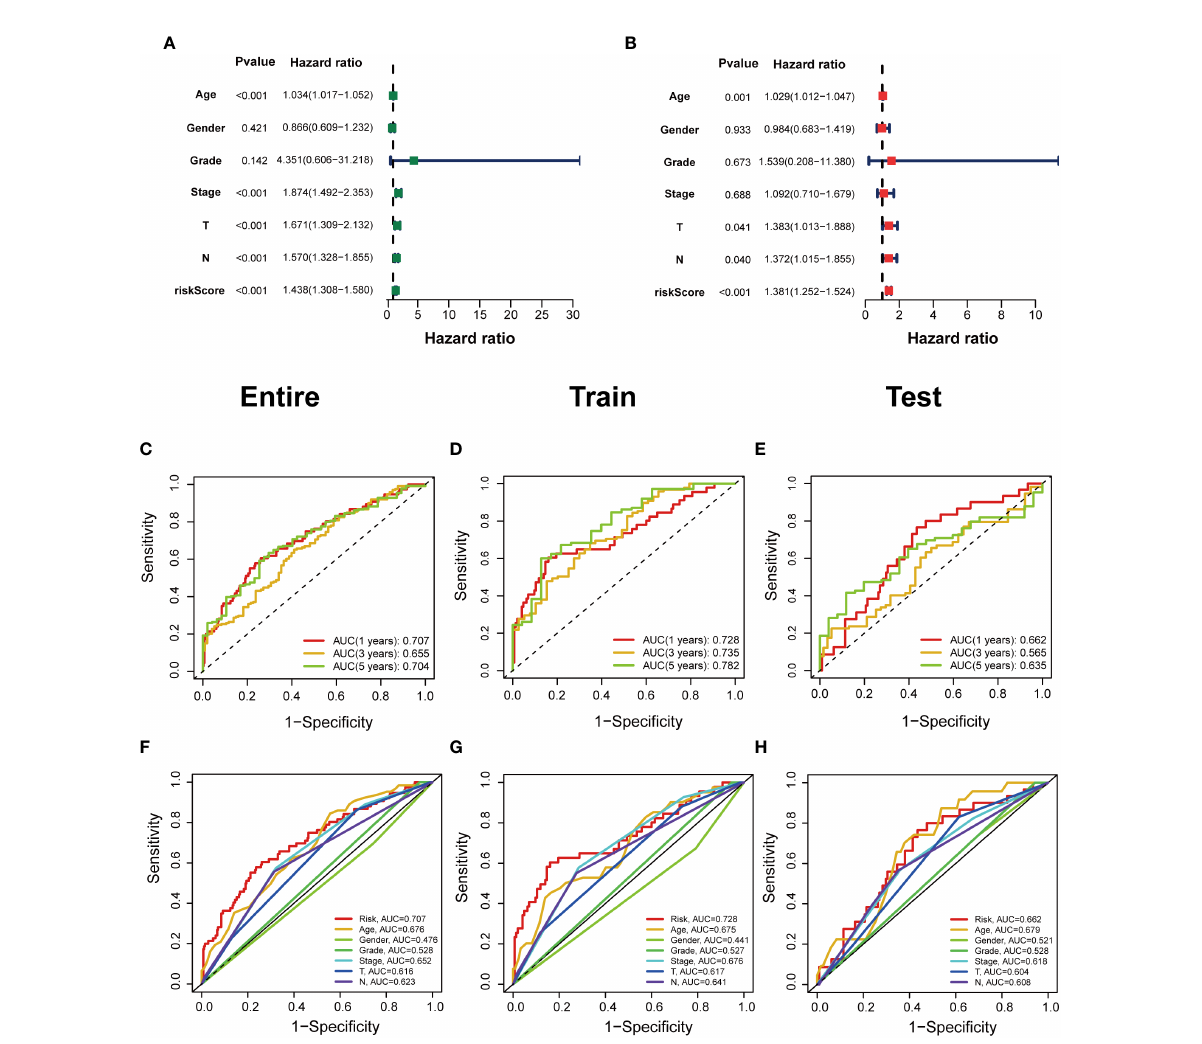
FIGURE 5 Independent prognostic value of clinical features in risk models. (A, B) Univariate Cox regression analysis and multivariate Cox regression analysis of clinical factors and risk scores. (C – E) Time-dependent ROC curves predict 1-year, 3-year, and 5-year overall survival for BCa patients in the entire; train; and test sets. (F – H) Multivariate time ‐ dependent ROC curve predicted the AUC for age, gender, grade, stage, T, N, and risk score of the total survival for 1 ‐ year in the entire; train; and test